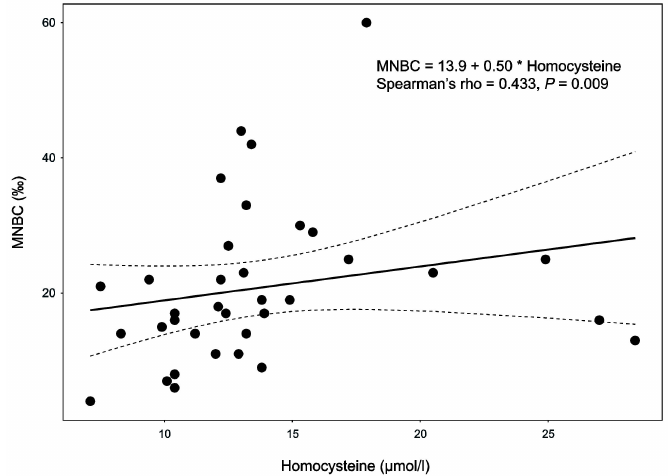
Figure 1. Relationship between micronucleated binucleated cells (MNBC) and serum levels of homocysteine after Goeckerman therapy. The solid line depicts linear regression fit with the 95% confidence boundaries plotted as dashed